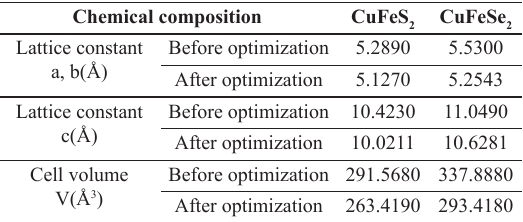
Table 1. Lattice constants and unit cell volumes of CuFeSe CuFeS before and after 2